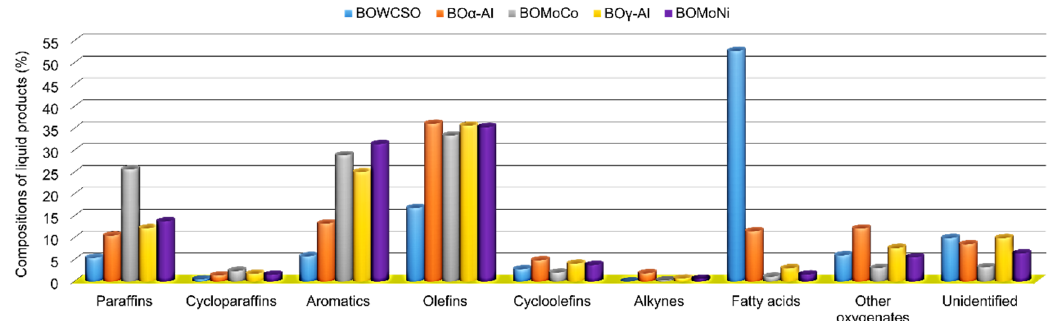
Figure 5. Effect of the different catalysts on the relative compositions of the liquid products.